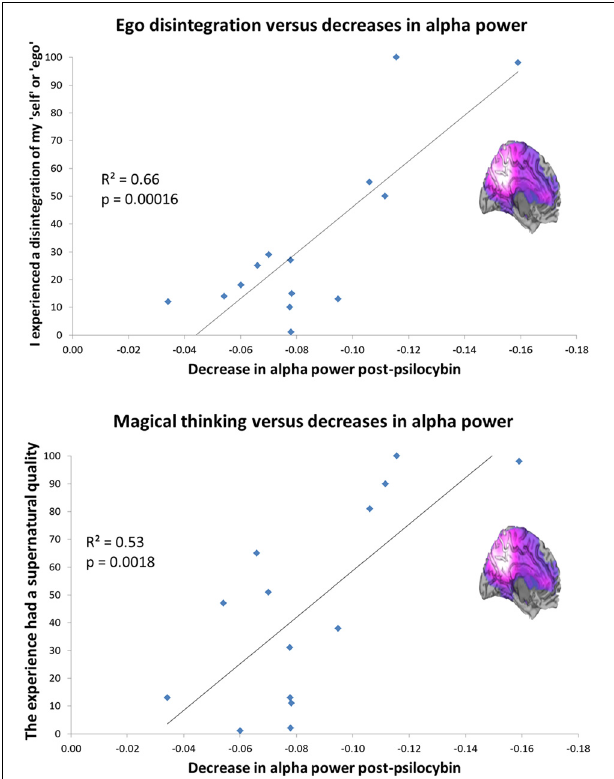
FIGURE 4 | Decreased PCC alpha power predicts ego-disintegration and magical thinking after psilocybin. Top: Decreased PCC alpha power v ratings of ego-disintegration. Bottom: Decreased PCC alpha power vs. ratings of magical/supernatural thinking. Both correlations were significant after correction for multiple comparisons (0.05/23 = 0.002). These charts are derived from data discussed in Muthukumaraswamy et al.